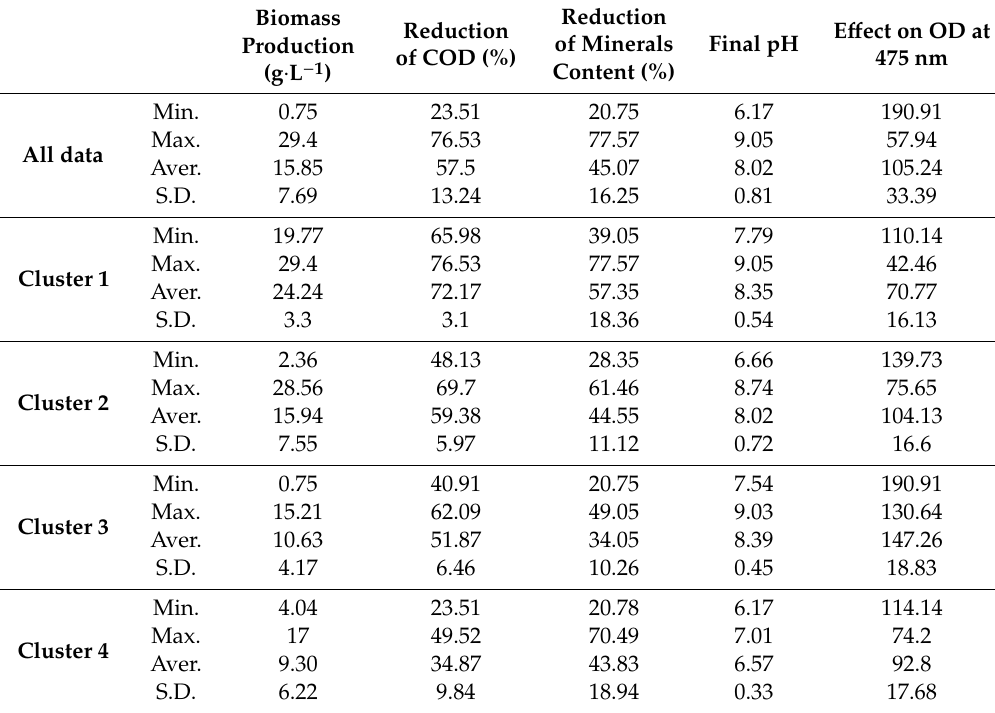
Table A3. PCA and HCA data related to the five original